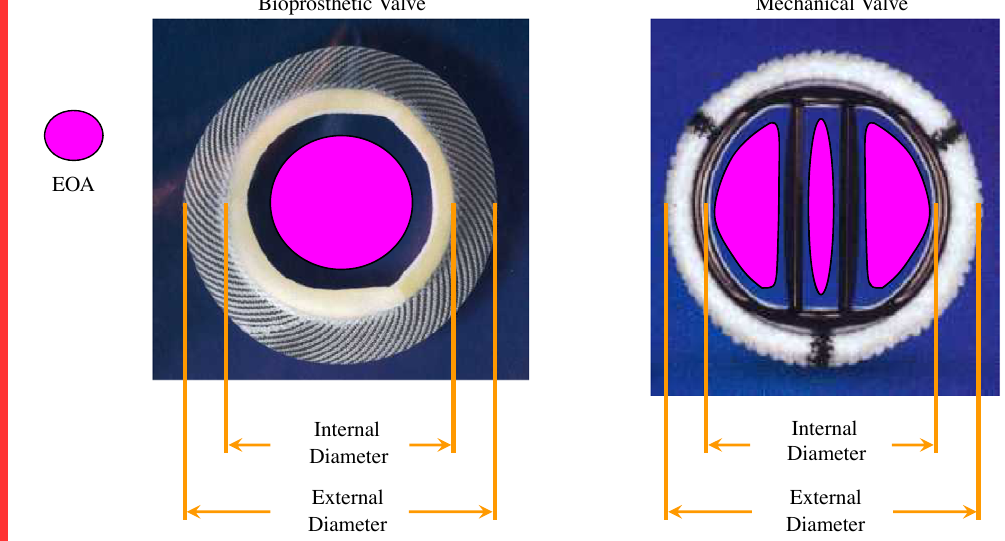
Figure. 1 View of a bioprosthesis and a bileaflet mechanical valve with the leaflets in a fully open position. The area highlighted in green represents the effective orifice area (EOA) (Reproduced and modified from Cardiac Surgery Today with permission from Remedica Publishing [105].